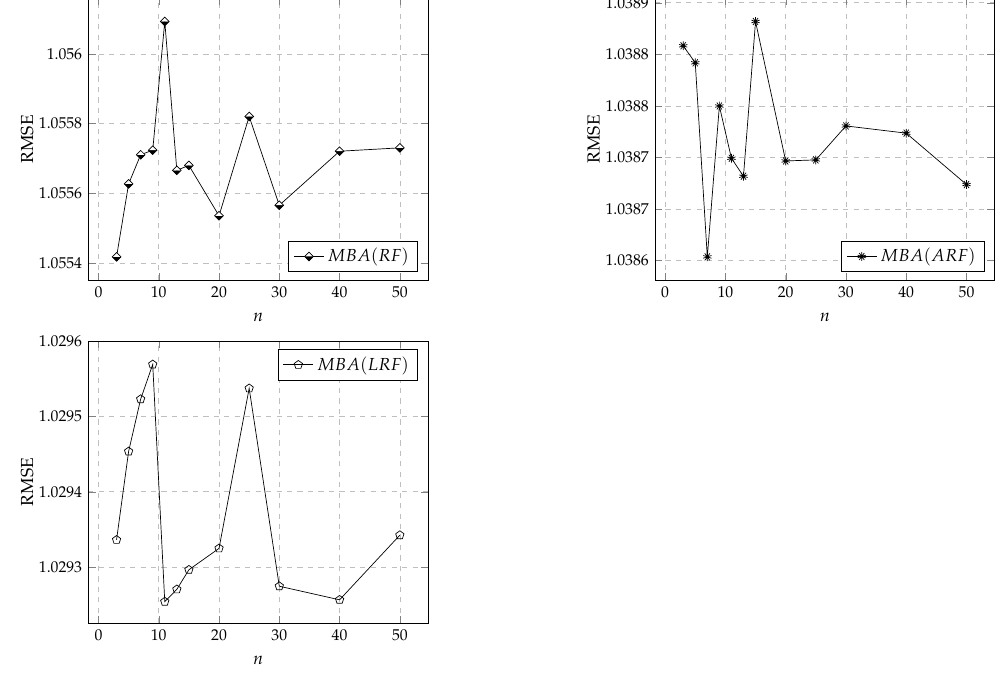
Figure A1. Comparison of RMSE in MBA(Vanilla) by n . MBA(RF) is best when n = 3, MBA(ARF) is best when n = 7 and MBA(LRF) is best when n = 11.